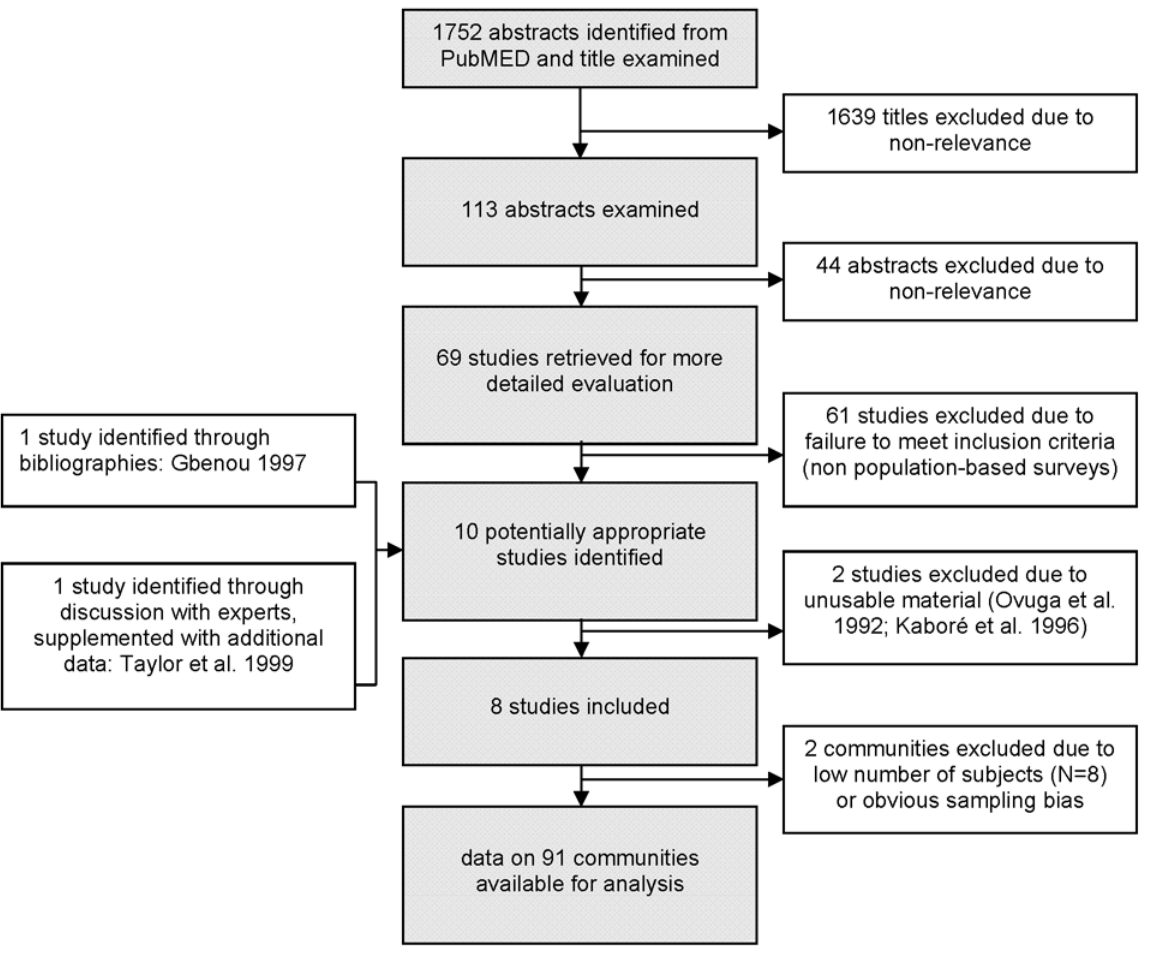
Figure 1. Flowchart summarizing the results of the search for papers on epilepsy potentially relating to onchocerciasis up to February 2008.